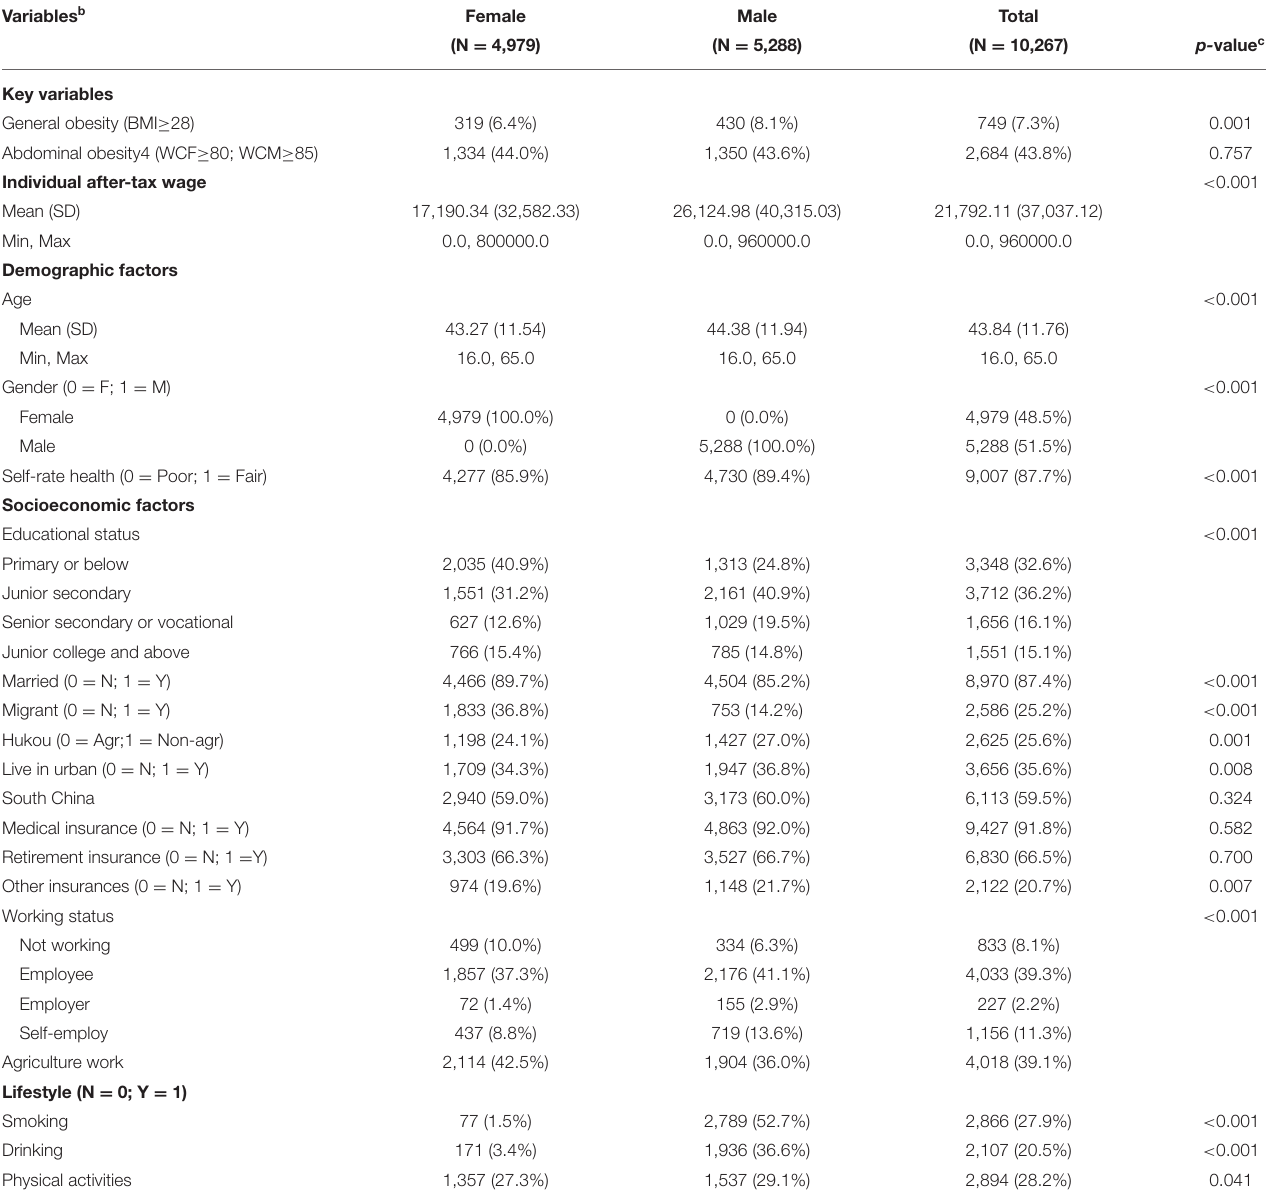
TABLE 1 | Variable statistics description, full, female, and male samples a . Variables